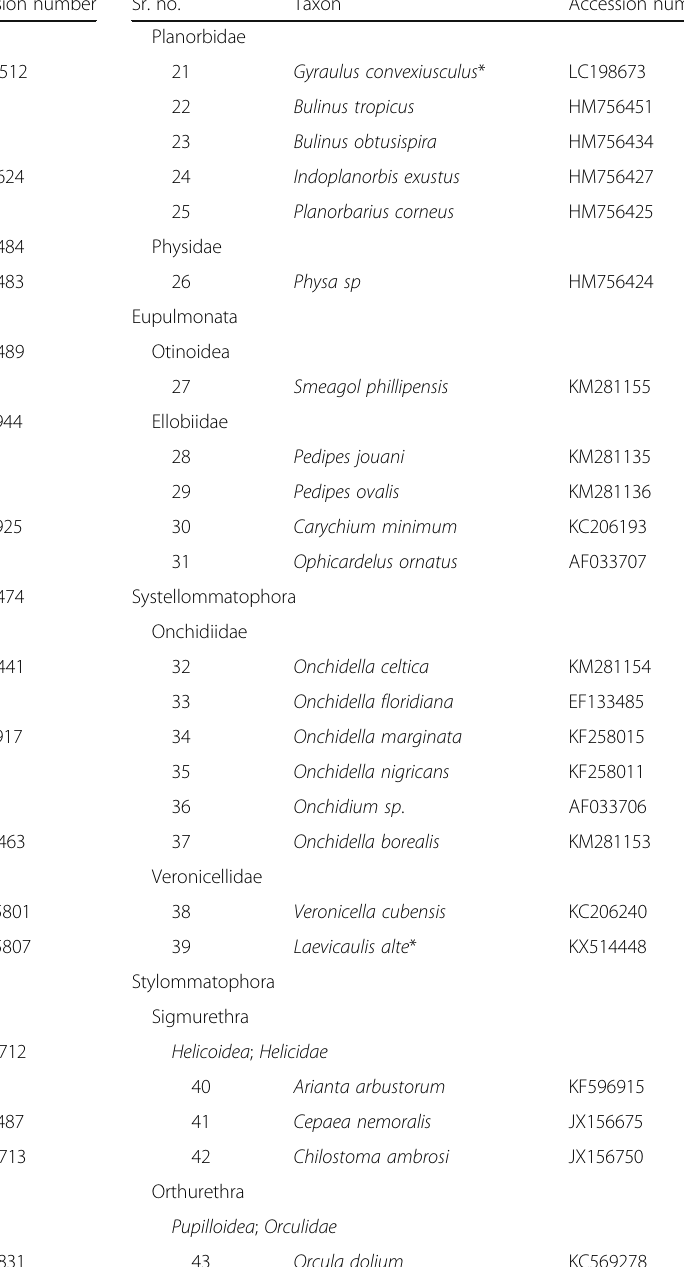
Table 1 List of taxa utilized in the present study (including the taxa sequenced in the present study — marked by asterisk), taxonomic position, and accession numbers Sr. no.